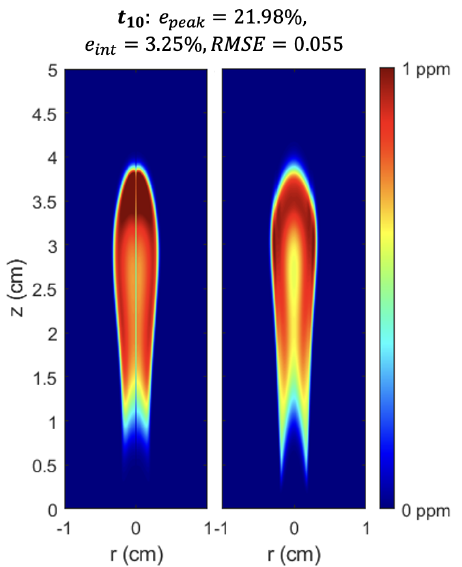
Figure 8. Soot volume fraction f v (ppm) compared between CFD and the neural network for the test data (the 10th time step). Left: LSTM neural network, right: